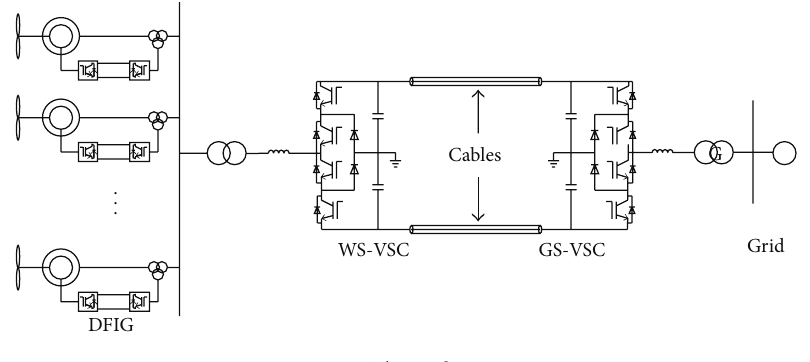
Figure 1: The study